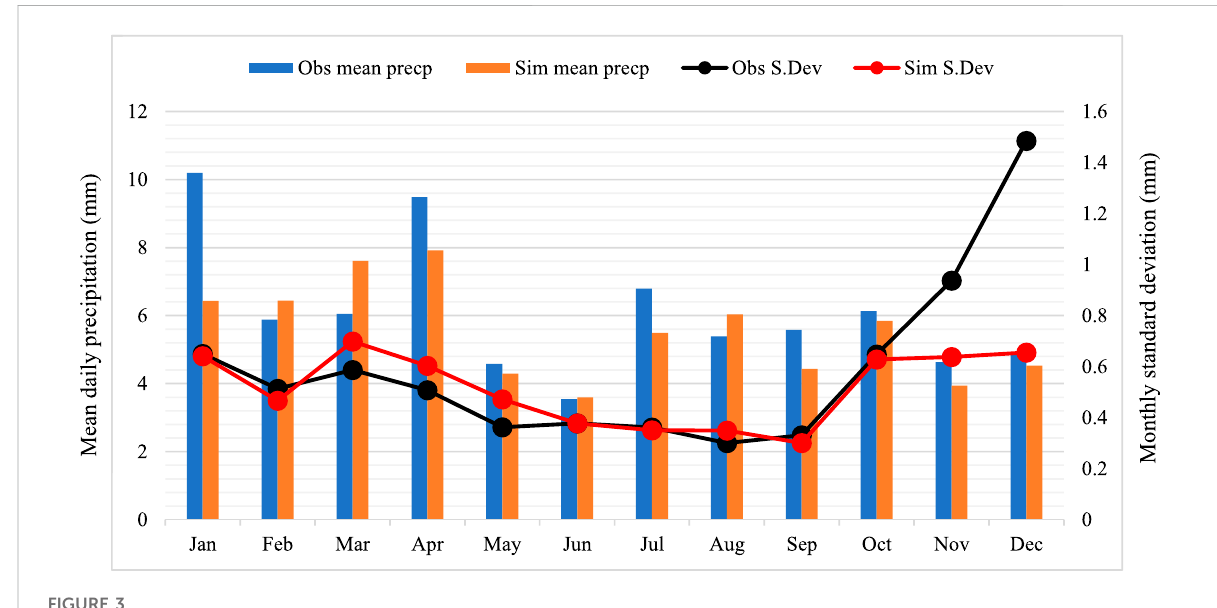
FIGURE 3 SDSM calibration of observed and simulated areal precipitation